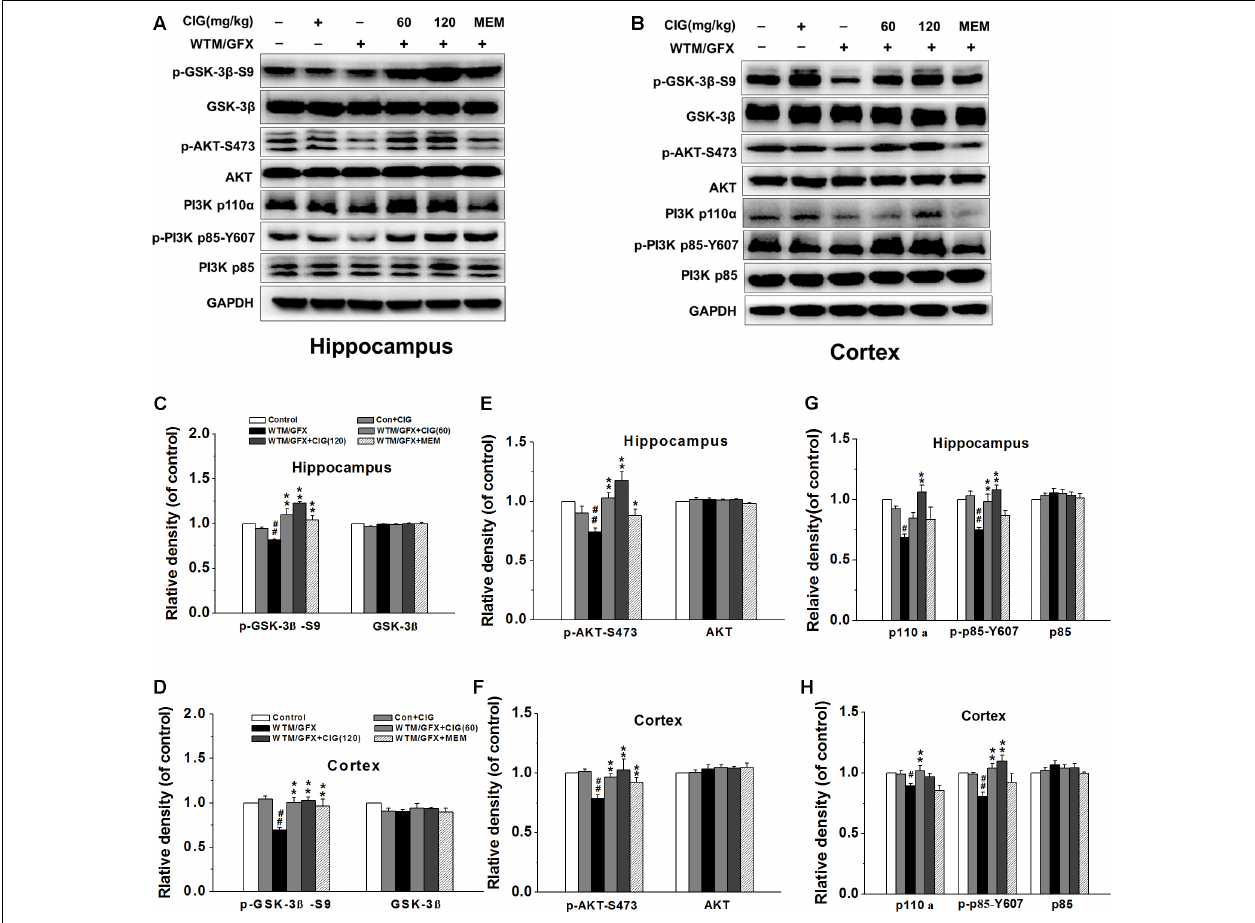
FIGURE 2 | Effects of CIG on GSK-3 β and PI3K/Akt signaling pathway in the hippocampus and cortex in wortmannin/GFX model rats. (A,B) The representative images of GSK-3 β , Akt and PI3K detected by western blotting analysis. (C,D) Quantitative analysis of GSK-3 β and phosphorylated GSK-3 β at Ser9. (E,F) Quantitative analysis of AKT and phosphorylated AKT at Ser473. (G,H) Quantitative analysis of PI3K p110 α , p85 and phosphorylated p85 at Tyr607. β -actin was used as an internal control, and the expression level of control group was set as 100%. Data are expressed as mean ± SD.; n = 4 per group. # P < 0.05, ## P < 0.01, the model group compared with the control group; ∗ P < 0.05, ∗∗ P < 0.01, the drug groups compared with the model group. WTM, wortmannin; GFX, GF-109203X; MEM, memantine, 3